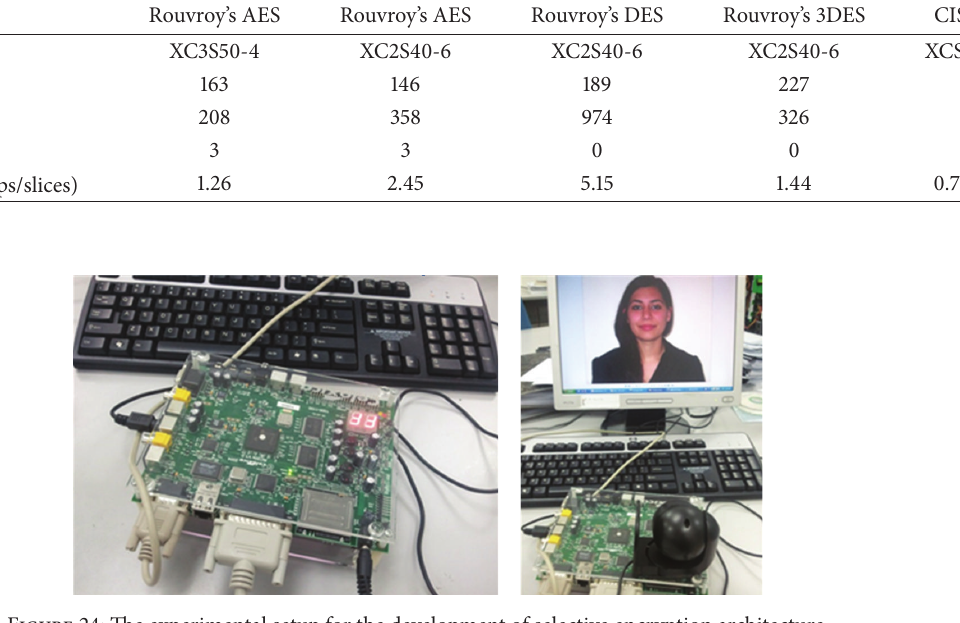
Figure 24: The experimental setup for the development of selective encryption architecture.